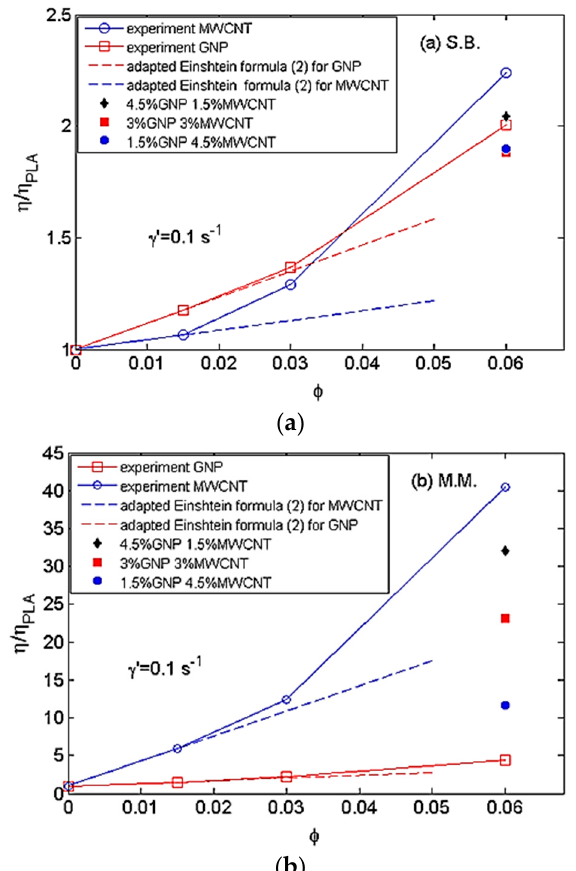
. γ = 0.1 s − 1 for the GNP/PLA